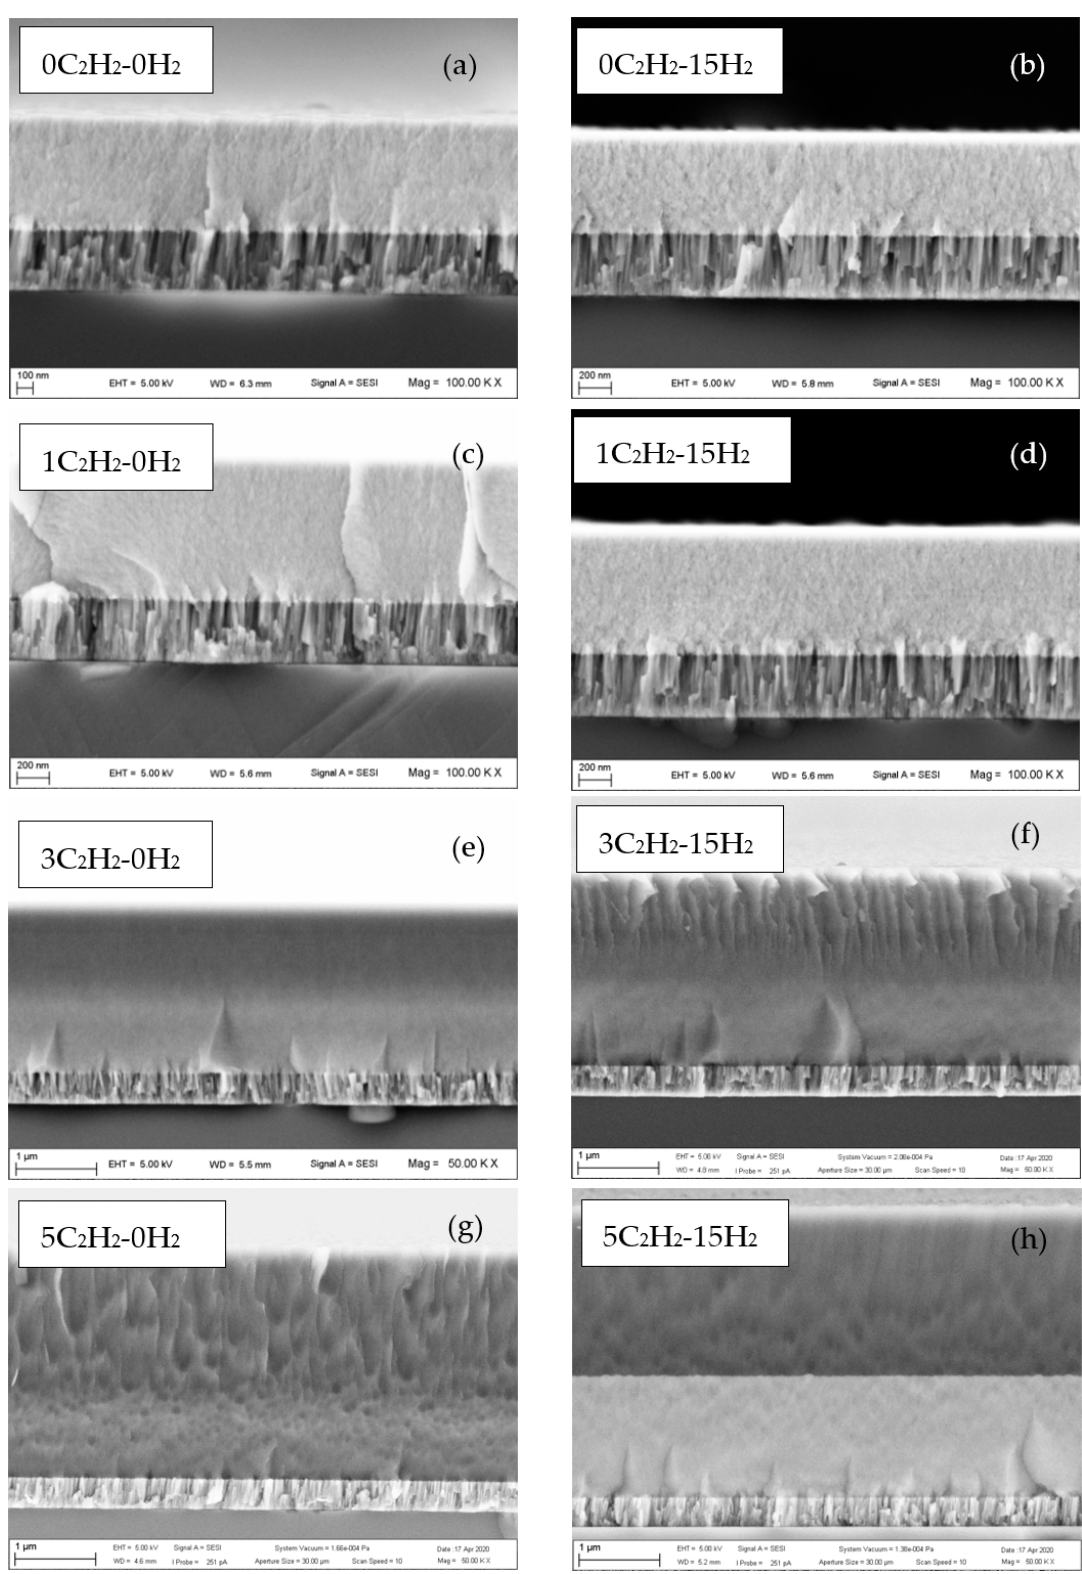
Figure 1. SEM micrographs of the fractured cross-sections of the studied W-C/:H coatings on Si substrates deposited with different additions of acetylene and hydrogen during hybrid PVD–PECVD process. Note that the magnifications in ( a – d ) micrographs are twice as high as in ( e – h ) coatings. The reason for two zone structure in 5C2H2-15H2 coating is not clear.